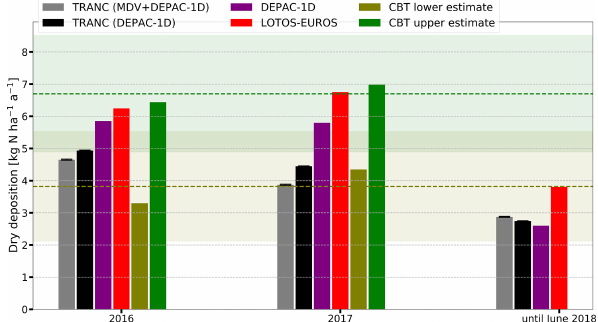
Figure 8. (cid:54) N r dry deposition for the years 2016 and 2017 and from January to June 2018 shown as a bar chart. Colors indicate different methods: TRANC(DEPAC-1D) (black), TRANC(MDV + DEPAC- 1D) (gray), DEPAC-1D (purple), LOTOS-EUROS (red), and canopy budget technique (olive and green). Data from TRANC, DEPAC-1D, and LOTOS-EUROS range from January 2016 to June 2018. CBT’s lower and upper estimates weighted according to the measured land use. The colored dashed lines indicate that the averaged dry deposition of the lower and upper estimates (dashed, brown line and dashed, olive line, respectively) were from 2010 to 2018; the shaded areas represent their standard